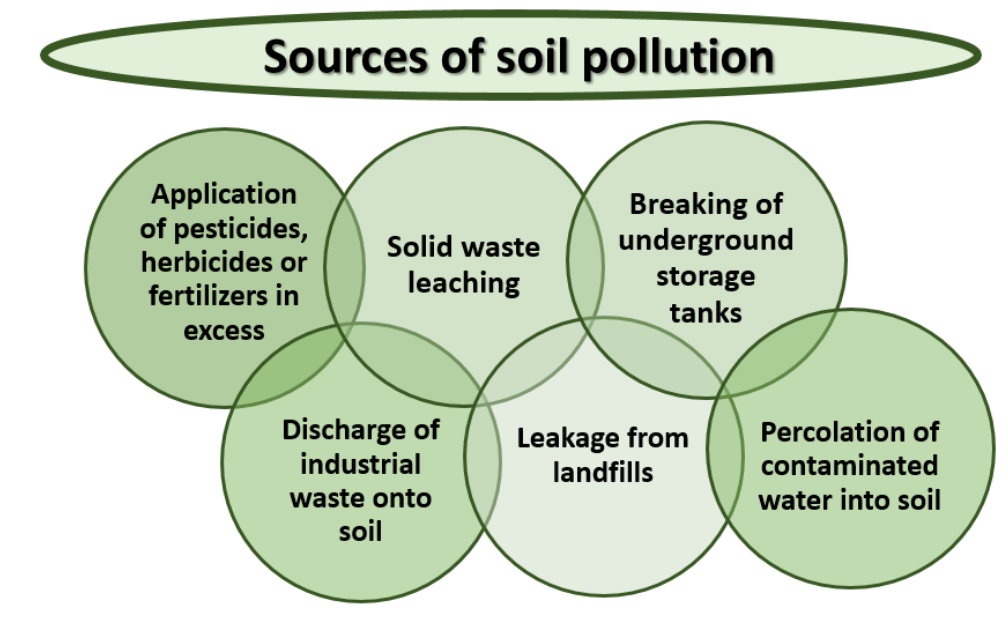
Figure 6. Some relevant sources of soil pollution.